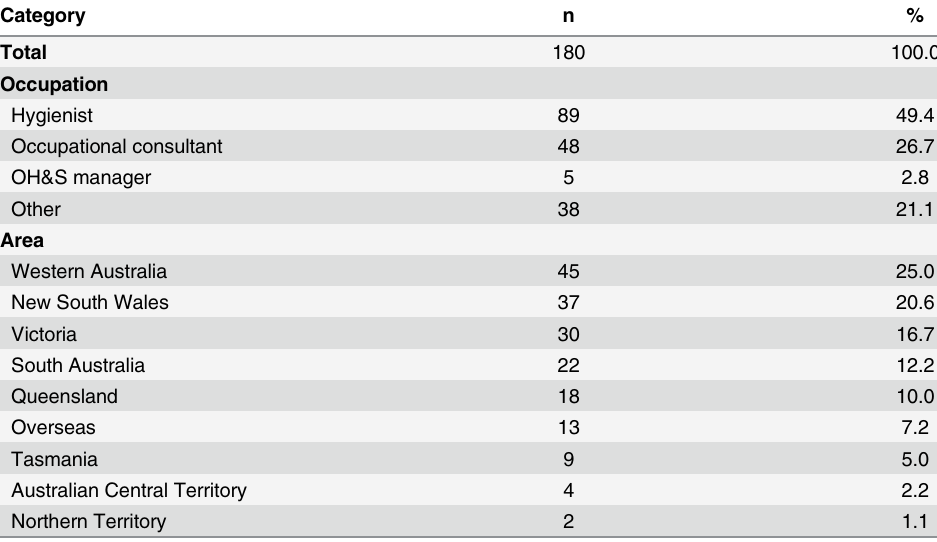
Table 1. Demographic information of the